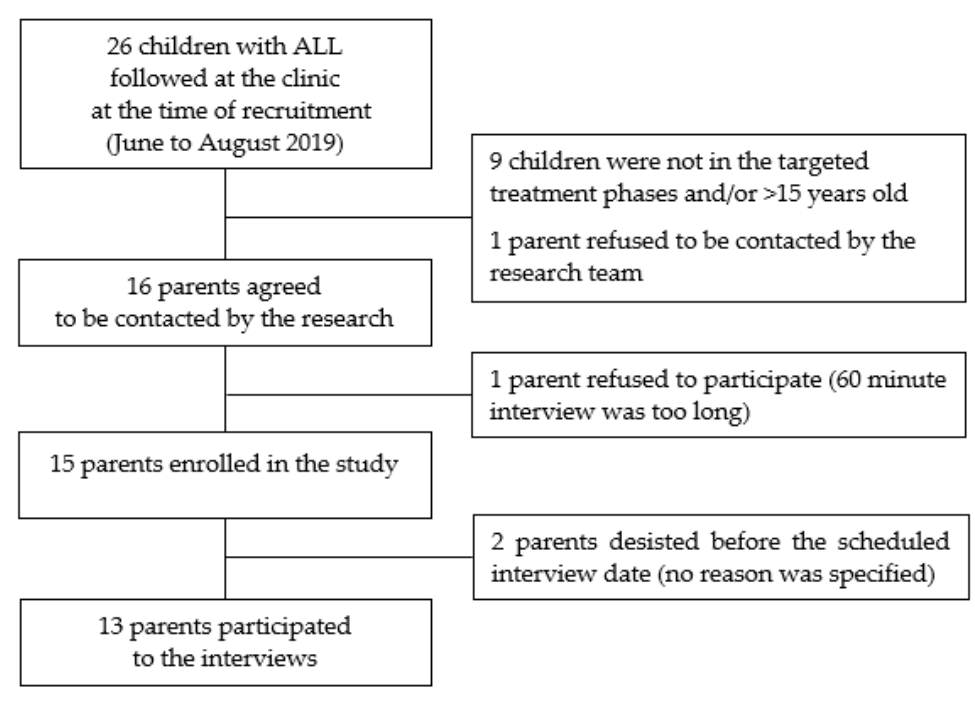
Figure 1. Study participants. Table 1. Parents’ and children’s